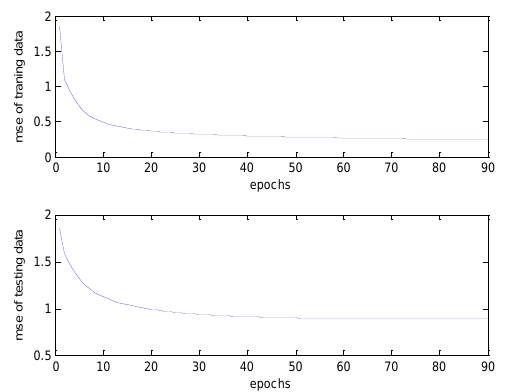
Figure 6. Learning rate is smaller than the upper limit